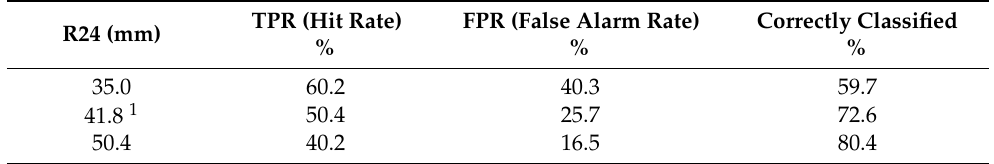
Table 6. Selected R24 thresholds for damage occurring in the municipality of Athens for different trade-offs among TPR and